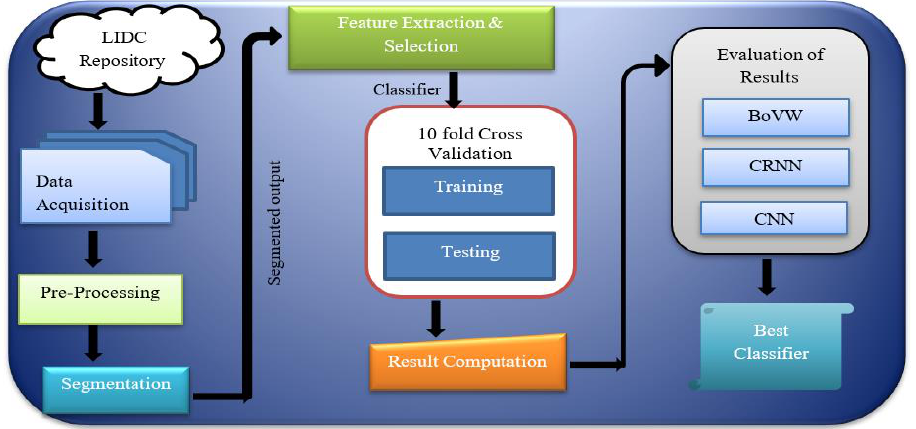
Figure 1. Block diagram of the cancer detection method.